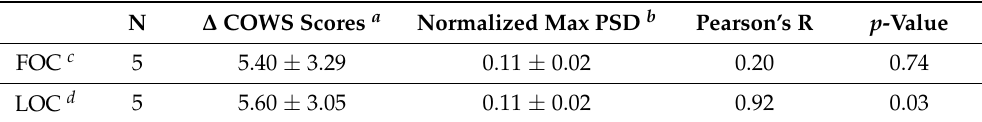
Table 1. A significant correlation between the overall COWS scores changes and the normalized max PSD occurred during the LOC for “Sinusoidal Patients” with positive COWS scores, indicating deterioration of “Sinusoidal Patients” with positive COWS scores